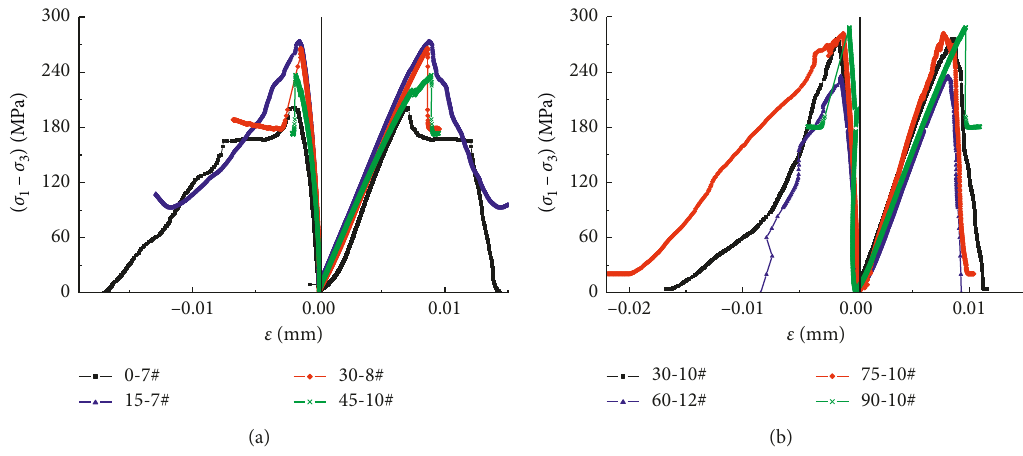
Figure 10: The stress-strain curves of the specimens: confining pressure of